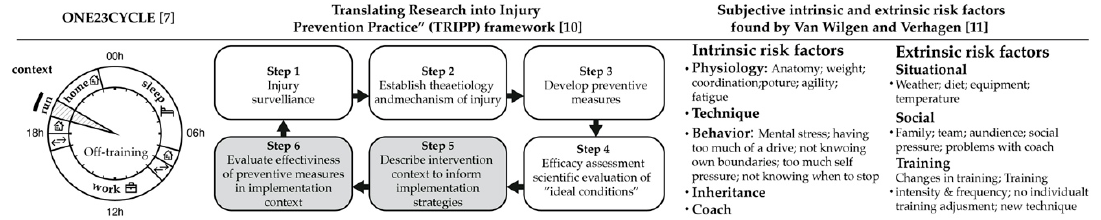
Figure 1. Approaches that articulate context, subjective, and 24/7 factors for injury prevention research and